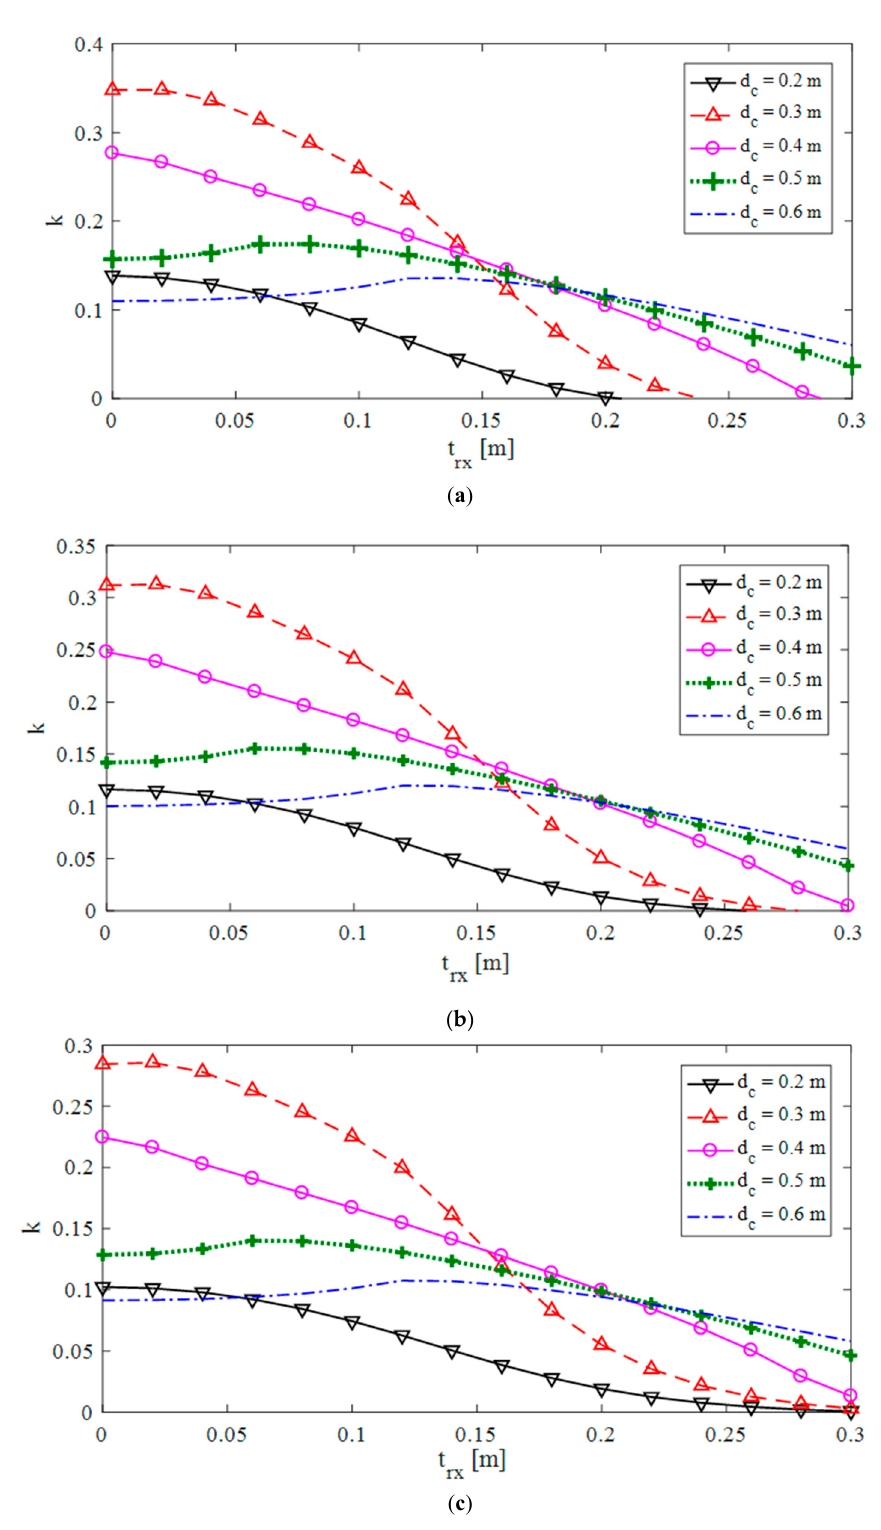
Figure 7. Coupling factor k versus lateral misalignment t rx along x -axis for circular coil, for different landing gear height: hs = 0.1 m ( a ), hs = 0.15 m ( b ) and hs = 0.2 m ( c ).